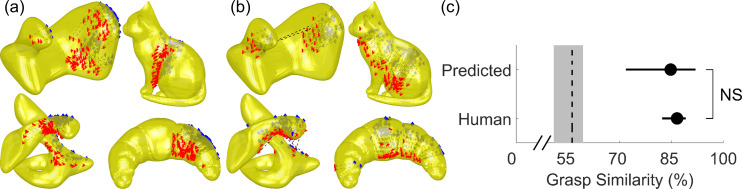
Model predictions for novel objects align with human grasps.(a) Grasping patterns predicted through the normative framework for novel objects with smooth and curved surface geometry. (b) Human grasps onto 3D printed versions of the objects align with model predictions. (c) Similarity of human and predicted model grasps to medoid human grasp across objects and participants. Dashed line is estimated chance level of grasp similarity, bounded by 95% bootstrapped confidence intervals.